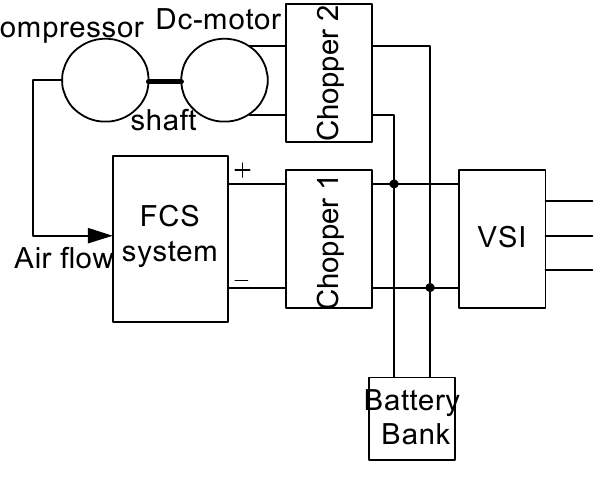
Figure 2. DC Side Configuration.